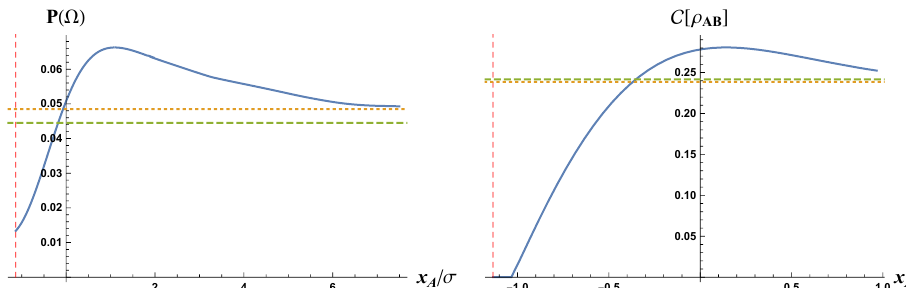
Figure 6 . Derivative coupling results. Left : the use of derivative coupling removes the IR ambiguity in the free-space P ((cid:10)) (dashed, green). The probability of excitation in the CW mirror spacetime now remains bounded at large x A =(cid:27) . It asymptotes to a value (dotted, yellow) slightly higher than the free-space result. Right : the concurrence against x A =(cid:27) plot shows the same qualitative behaviour as linear coupling. Namely, we observe a region of entanglement enhancement and a region of entanglement death close to the mirror. The concurrence will asymptote to a value (dotted, yellow) slightly below the free-space result (dashed, green). In this plot, (cid:20)(cid:27) = 0 : 5, (cid:10) (cid:27) = 1, t A =(cid:27) = 0 and (cid:1) x=(cid:27) =